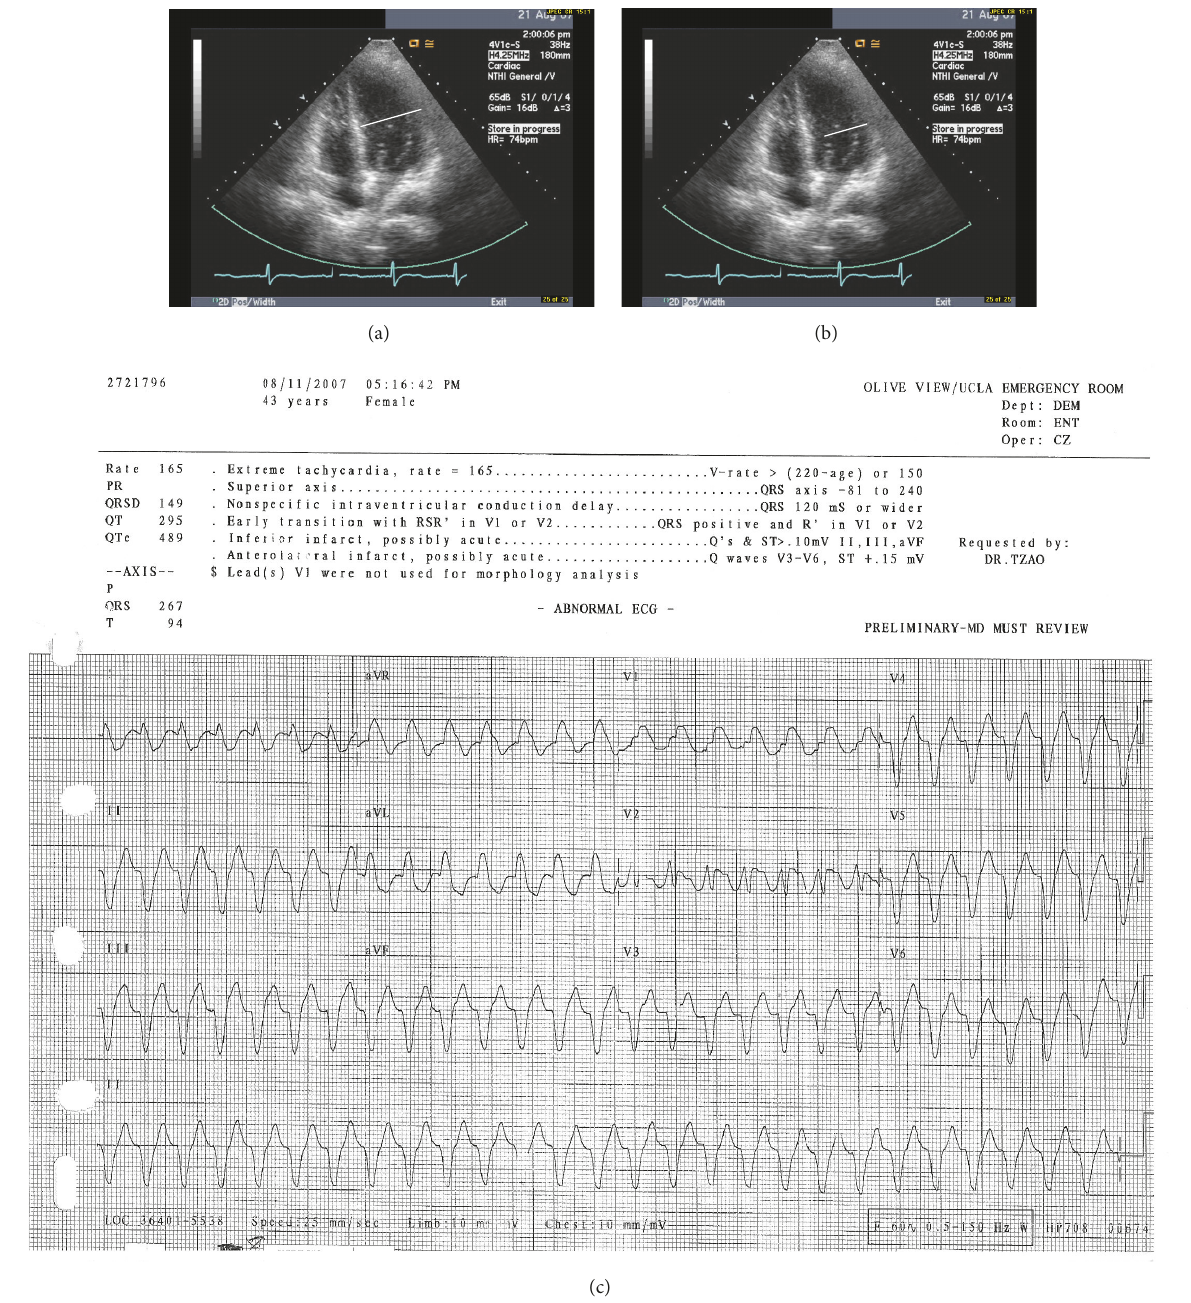
Figure 1: (a) Patient 08/11/2007 four-chamber view echocardiogram showing a dilated myocardium and an ejection fraction of 25% note sinus rhythm; (b) Patient 09/04/2007 four-chamber view echocardiogram showing less dilatation, movement of myocardium inward during systole, and an ejection fraction of 55%; (c) EKG showing monomorphic ventricular tachycardia due to GPA myocarditis and